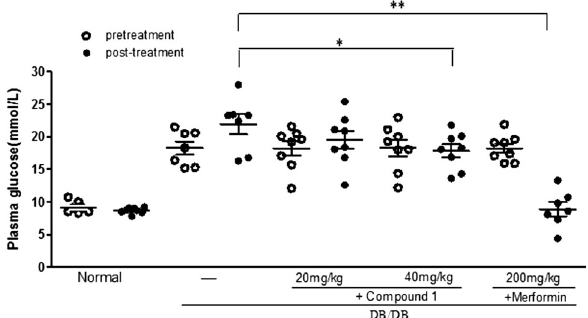
Fig. 4 Effects of compound 1 on glucose levels of db/db mice. Data are presented as mean ± SEM (n = 10 in each group). * P \ 0.05, ** P \ 0.01 (Dunnett’s test). Metformin served as a positive